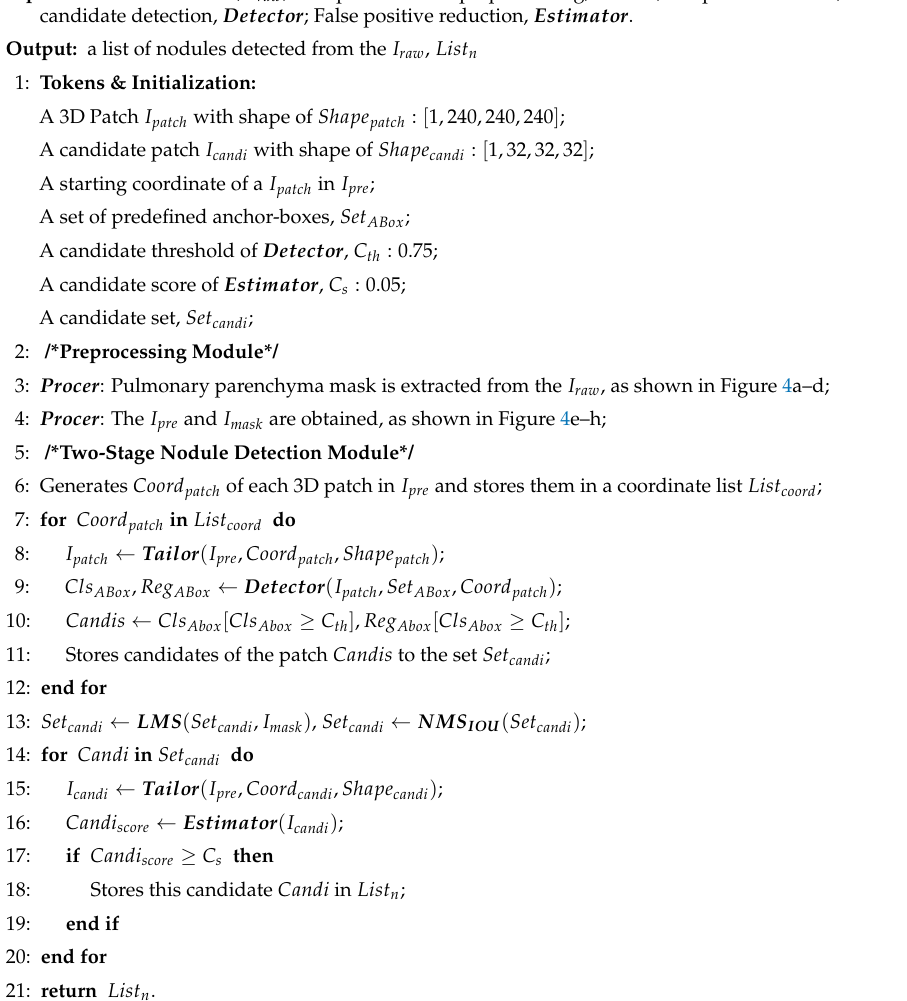
Algorithm 1 Pseudo code of the proposed nodule CAD